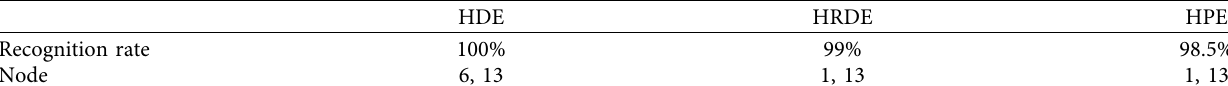
Table 4: Recognition rate of the optimal result of dual feature recognition for four types of